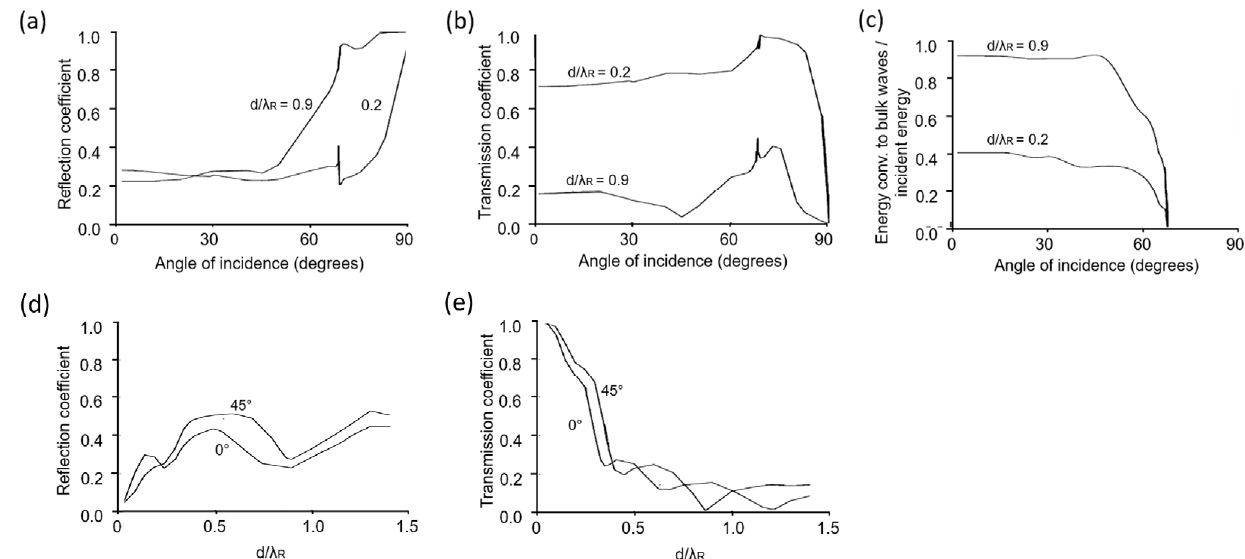
Figure 4. Theoretical results for the scattering of Rayleigh waves at a surface breaking crack (data taken from Angel and Achenbach 1984 [11], for a Poisson’s ratio ν = 0.3. Reflection ( a ), transmission ( b ), energy conversion to bulk waves ( c ) depending on the angle of incidence, as well as reflection ( d ) and transmission ( e ) as a function of crack depth d divided by the wavelength 𝜆